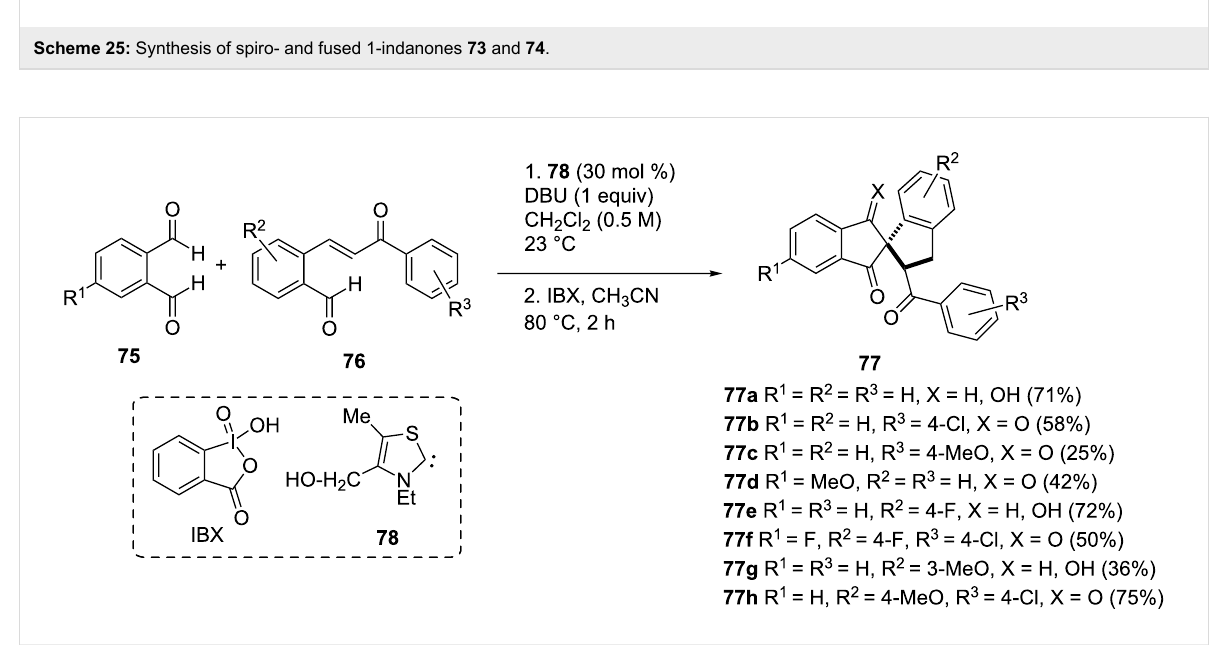
Scheme 26: Synthesis of spiro-1,3-indanodiones 77